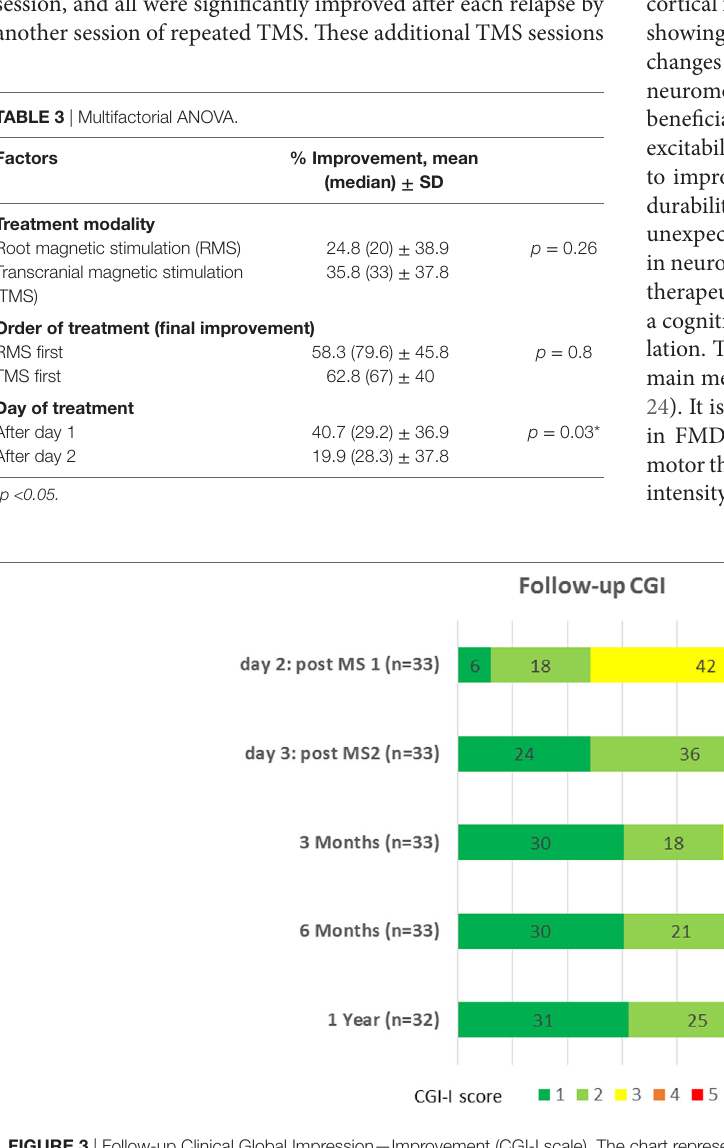
FigUre 3 | Follow-up Clinical Global Impression—Improvement (CGI-I scale). The chart represents the % of patients in each CGI-I score group. A CGI-I score is defined as follows: 1: very much improved; 2: much improved; 3: minimally improved; 4: no change; and 5: minimally worse.